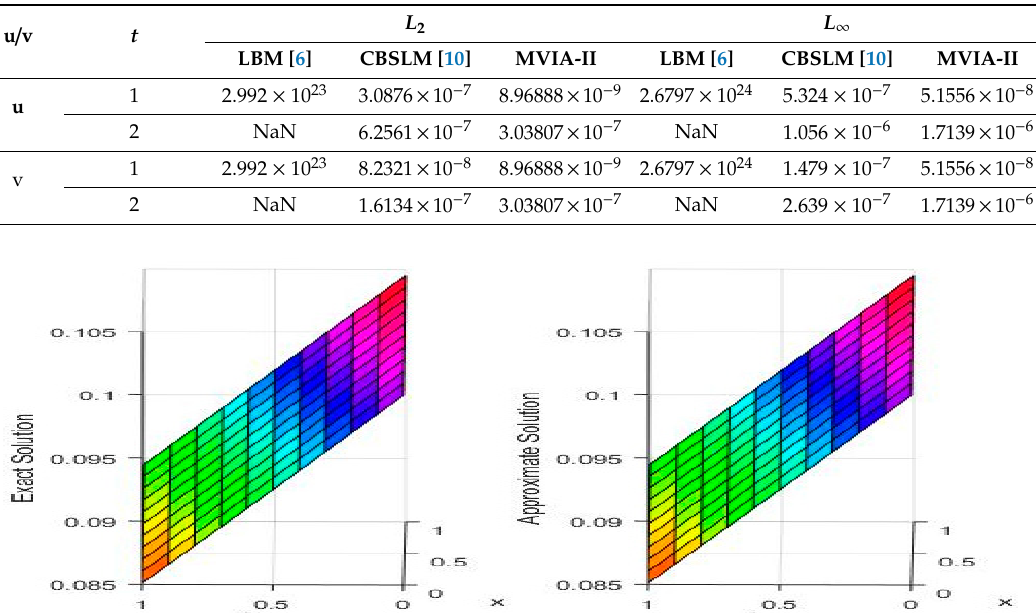
Figure 5. Behavior of exact ( Left ) and approximate solution ( Right ) for Test Problem 2.